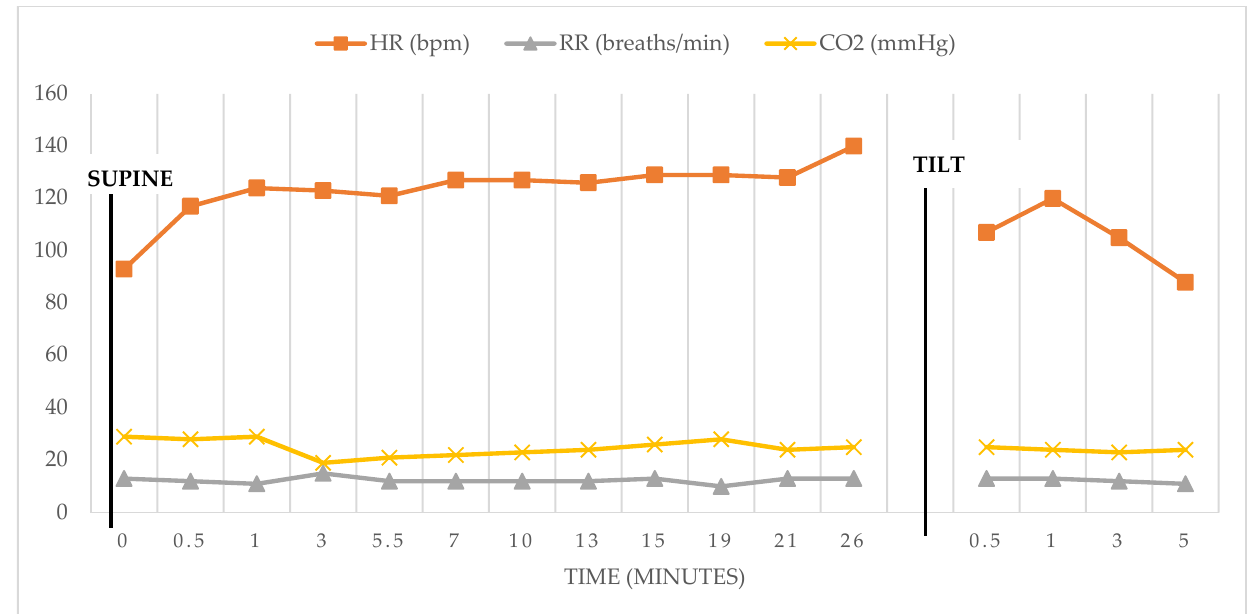
Figure 1. Beat-to-beat blood pressure (BP) response during the Valsalva maneuver. The VM consists